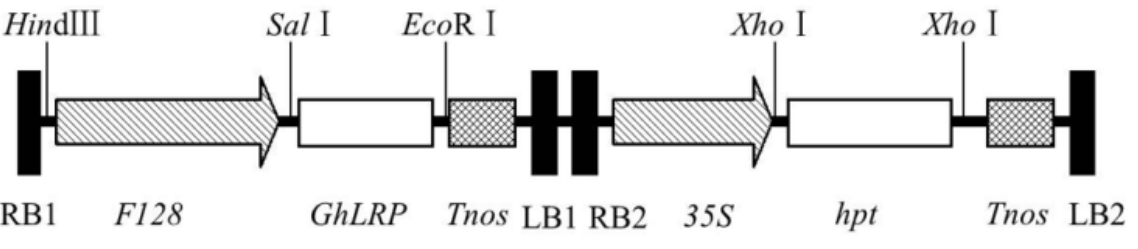
Figure 1. Schematic diagram of binary vector pSB130-GhLRP developed for maize transformation. The plasmid consisted of two T-DNAs. The right and left borders of the two T-DNAs are designated as RB1, LB1 and RB2, LB2, respectively. T-DNA1 contains the GhLRP expression cassette, in which the GhLRP gene is regulated by the promoter, F128, and the Nos terminator, and T-DNA2 includes the selectable marker gene, hpt , expression cassette controlled by the CaMV 35S promoter and the Nos